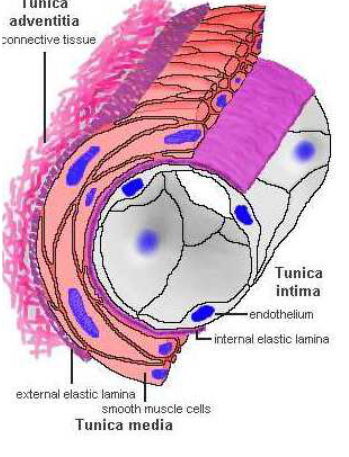
Figure 1. Cut-away view of an artery.